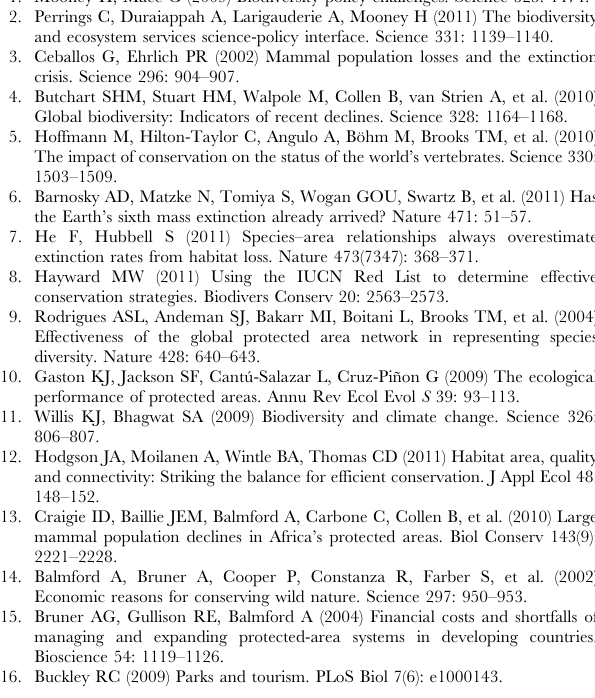
Table S1 Subpopulation data for red-listed mammal species in Table 1.